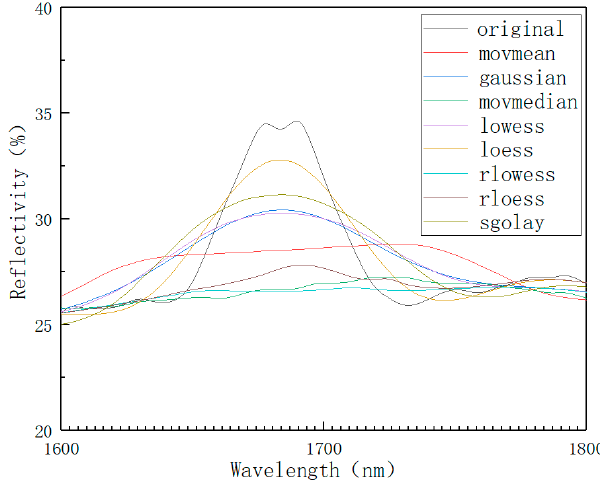
Figure 6. A 1600 nm~1800 nm band smoothing comparison chart.